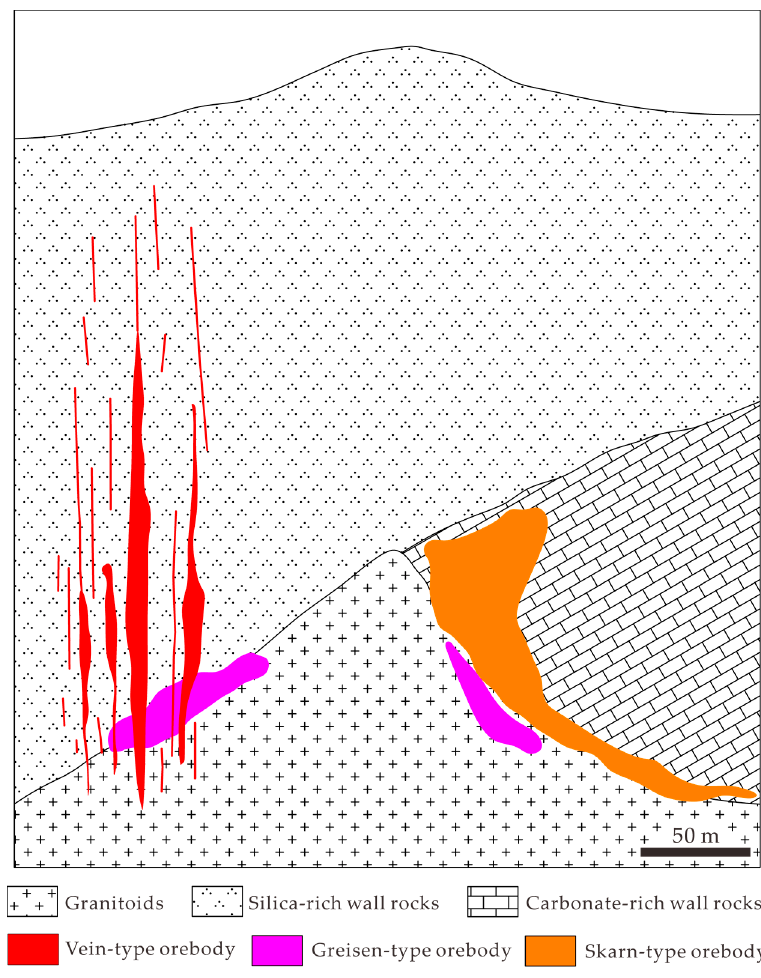
Figure 2. Sketch showing positions of different types of W mineralization relative to Yanshanian Figure 1. Sketch showing positions of di ff erent types of W mineralization relative to Yanshanian intrusions, modified from [42]. intrusions, modified from